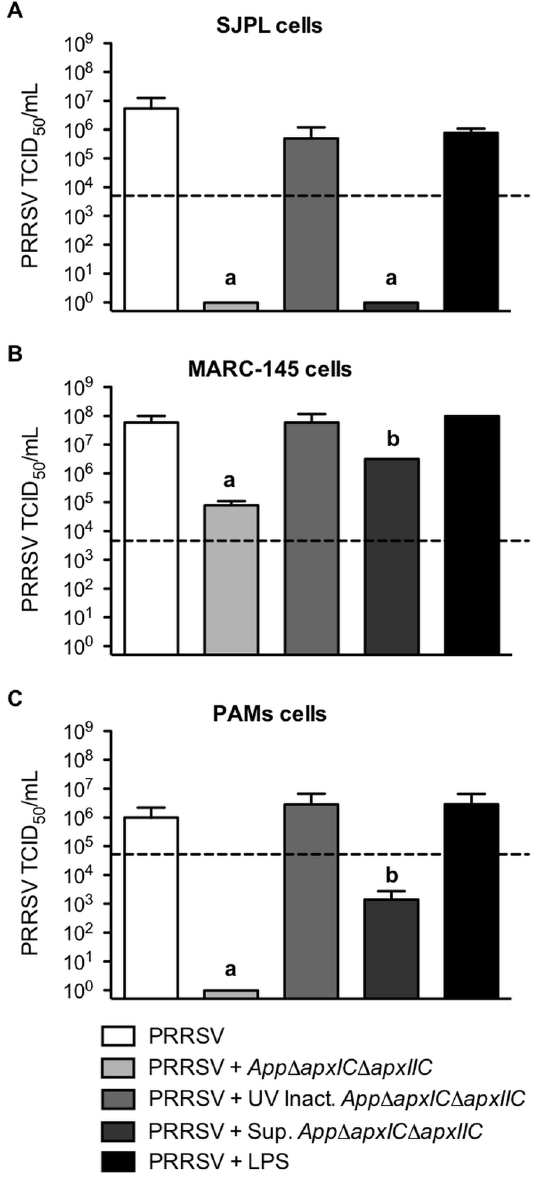
Figure 4. PRRSV titer in App treated SJPL, MARC-145 and PAM cells. SJPL (A), MARC-145 (B) and PAM (C) cells were infected with PRRSV MOI of 0.5 for 4 hours and then co-infected with App D apxI- D apxIIC MOI of 10, or with UV inactivated App D apxI D apxIIC MOI of 10, or treated with LPS (4 m g/ml) or culture supernatant of App D apxI D ap- xIIC for 48 hours. PRRSV titer was determined on MARC-145 cells by the Ka¨rber method. Values are presented as 6 Standard Deviation (SD). One-away ANOVA analysis was used to obtain statistical data. When bars within a cell type are labeled with superscripts letters, it indicates that these sets of data are statistically different from the other bars (P , 0.05).